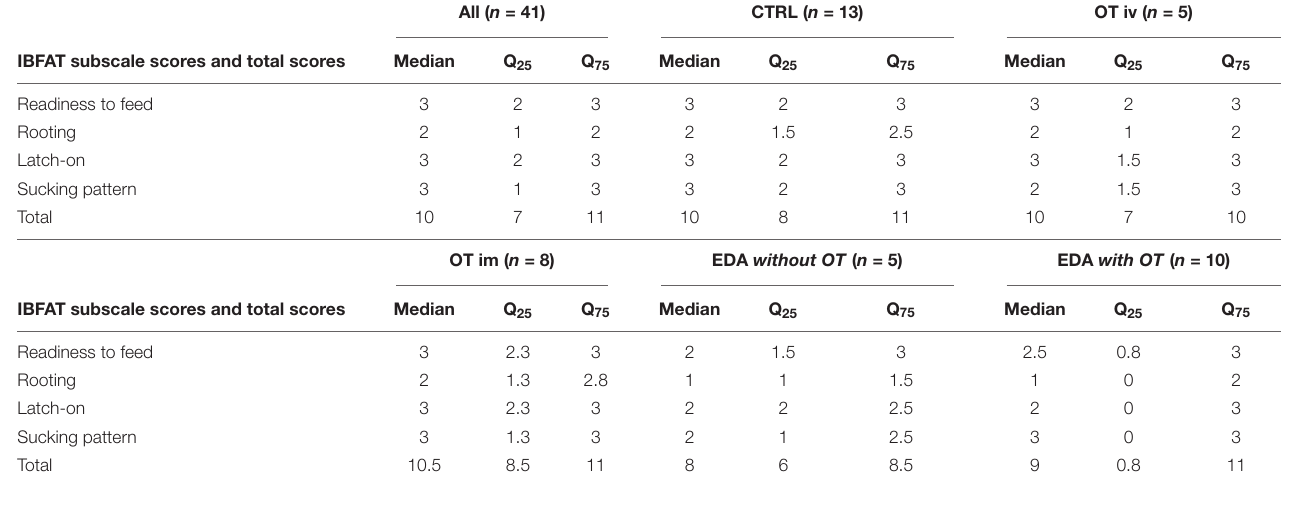
TABLE 5 | IBFAT subscale scores and total scores of all infants and as a function of the medical interventions the mothers had received during